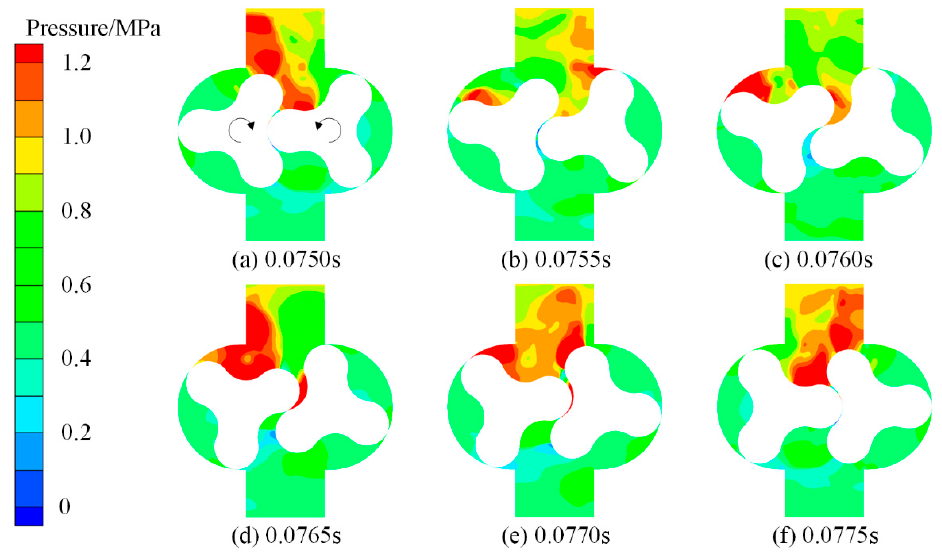
Figure 19. Static pressure contours of the Roots pump when the rotational speed is 4000 rpm. Flow time: ( a ) 0.0750 s; ( b ) 0.0755 s; ( c ) 0.0760 s; ( d ) 0.0765 s; ( e ) 0.0770 s; ( f ) 0.0775 s.